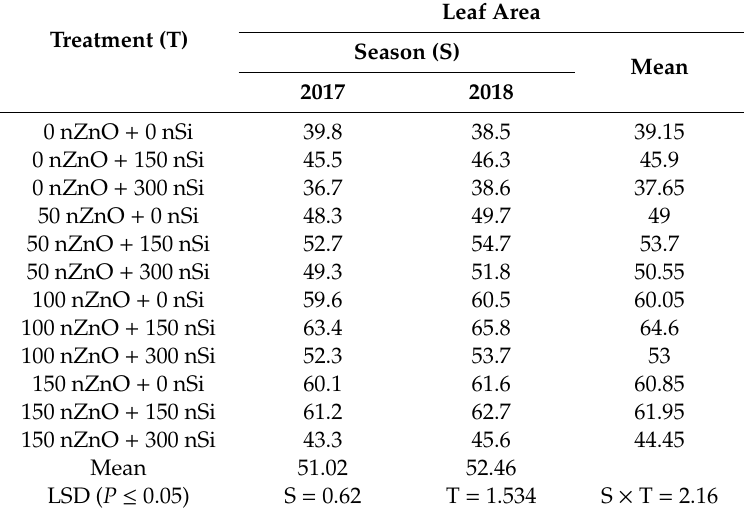
Table 2. E ff ect of foliar spray with ZnO and Si nanoparticles (NPs) (mg / L) on leaf area (cm 2 ) of “Ewais” mango trees during the 2017 and 2018